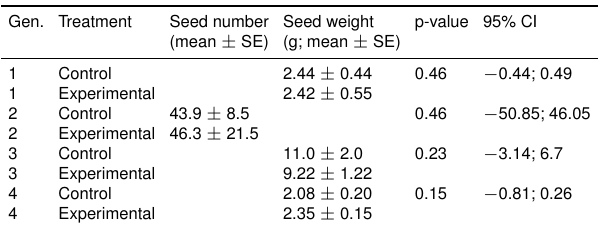
Table 1. Four generations biodynamic seed pepper treat- ments.